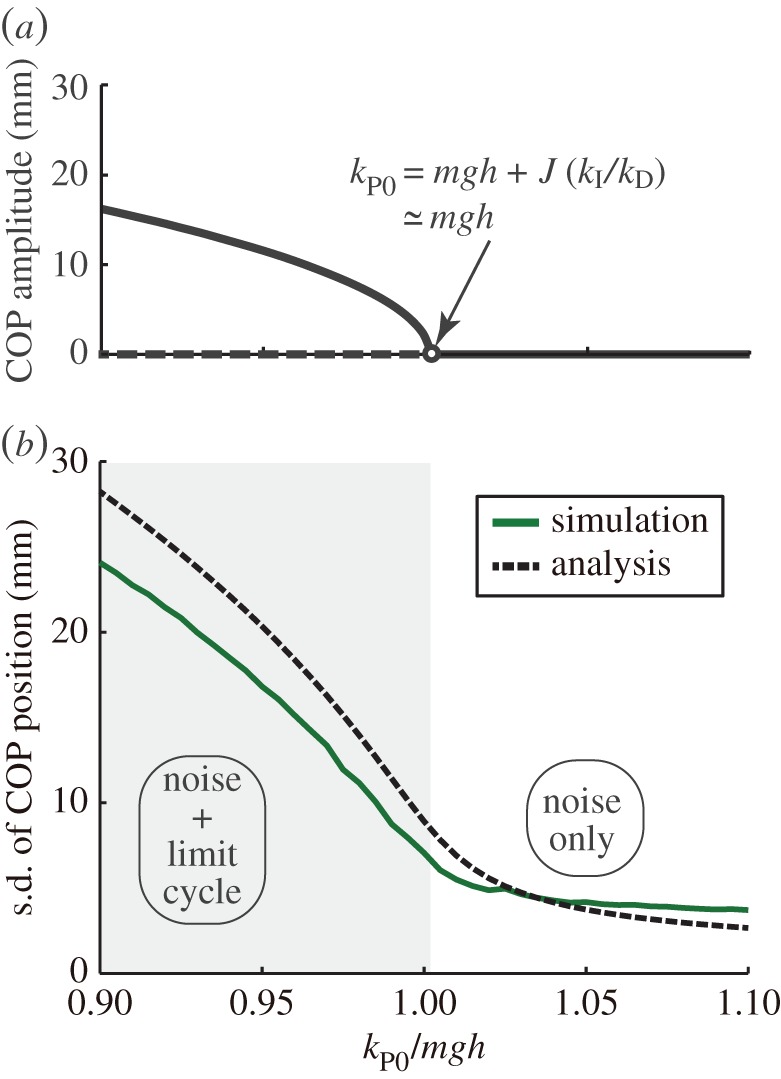
Characteristics of the system model. (a) Bifurcation structure of the system without noise. The solid line represents the stable solution, the dotted line represents the unstable solution and the white circle shows the bifurcation point. (b) Standard deviation of the COP in the system with noise. The system shows the limit cycle in the grey area. Transition between the stable stationary state and the limit cycle occurs continuously both in simulation (green line) and analytically (black dotted line).